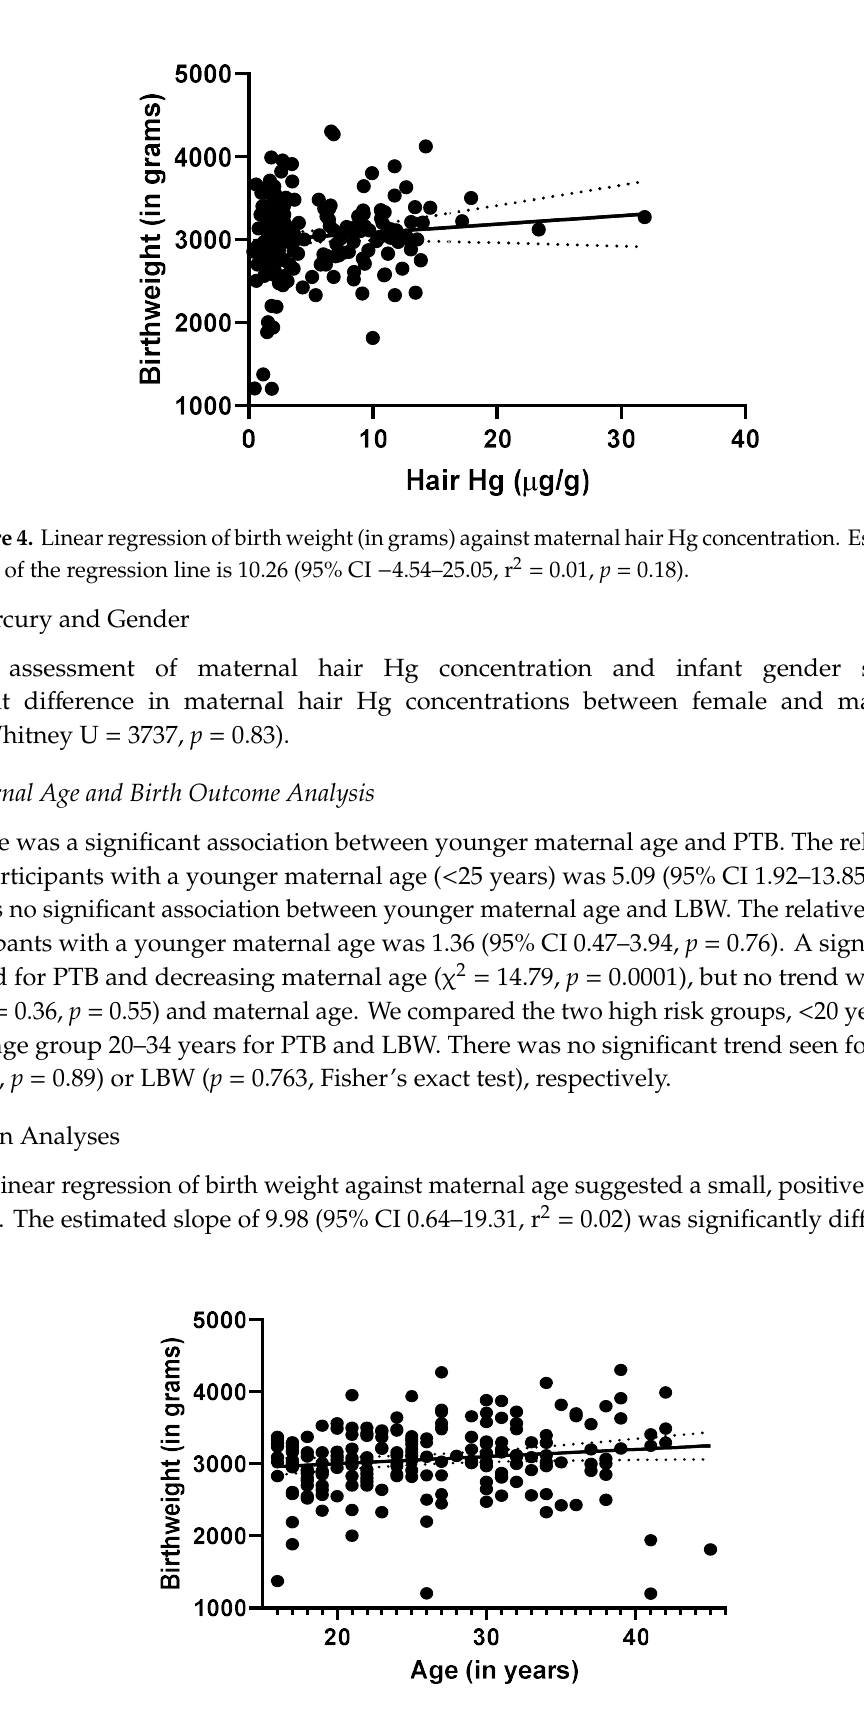
Figure 5. Positive relationship between maternal age (in years) and birth weight (in grams). Estimated slope of the regression line is 9.98 (95% CI 0.64–19.3, r 2 = 0.02, p <